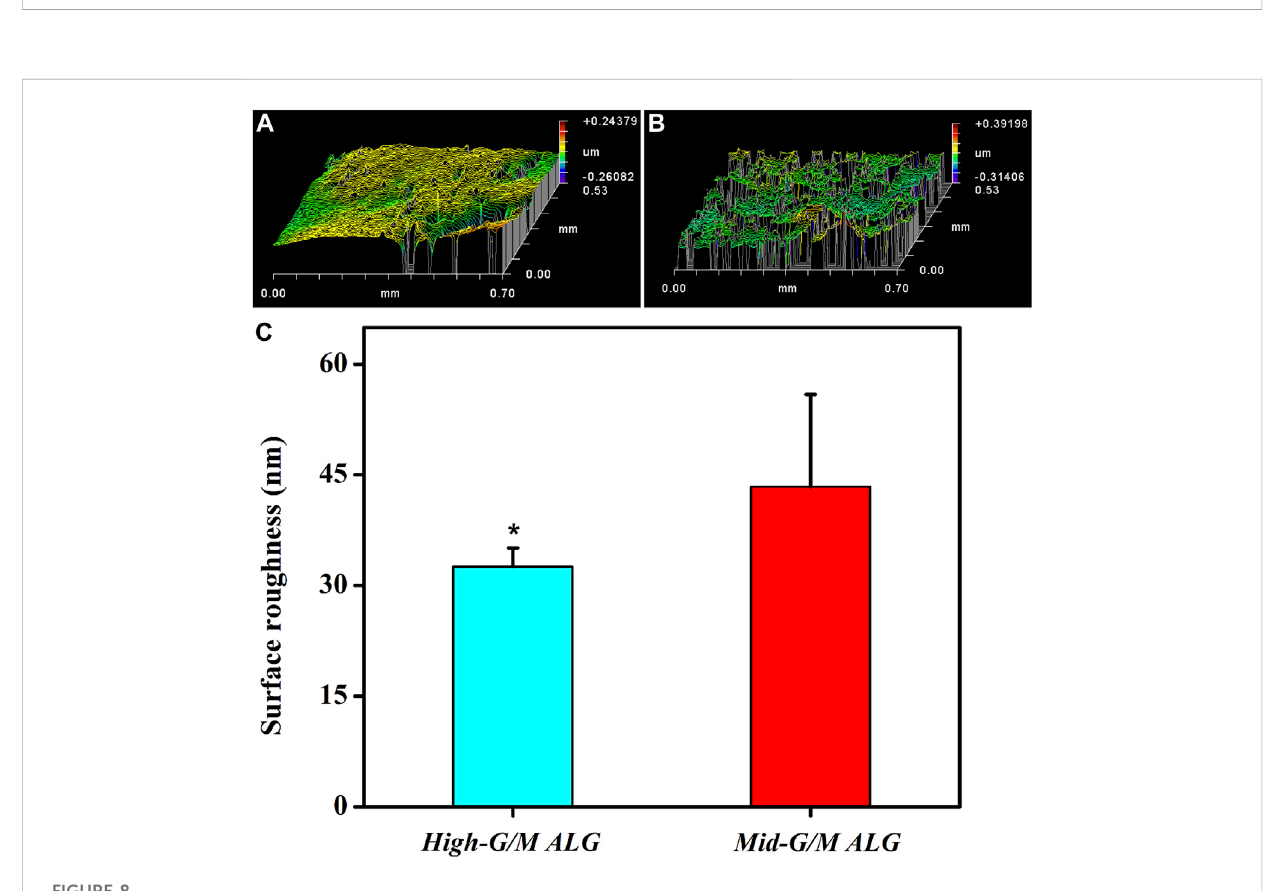
FIGURE 8 Representative images of the surface morphology of both hydrogels in a wet state: (A) High-G/M ALG/COL and (B) Mid-G/M ALG/COL. (C) Quantitative analysis of the surface roughness of the two types of hydrogels (* p < 0.05 indicates a signi fi cant difference in the number of experiments).